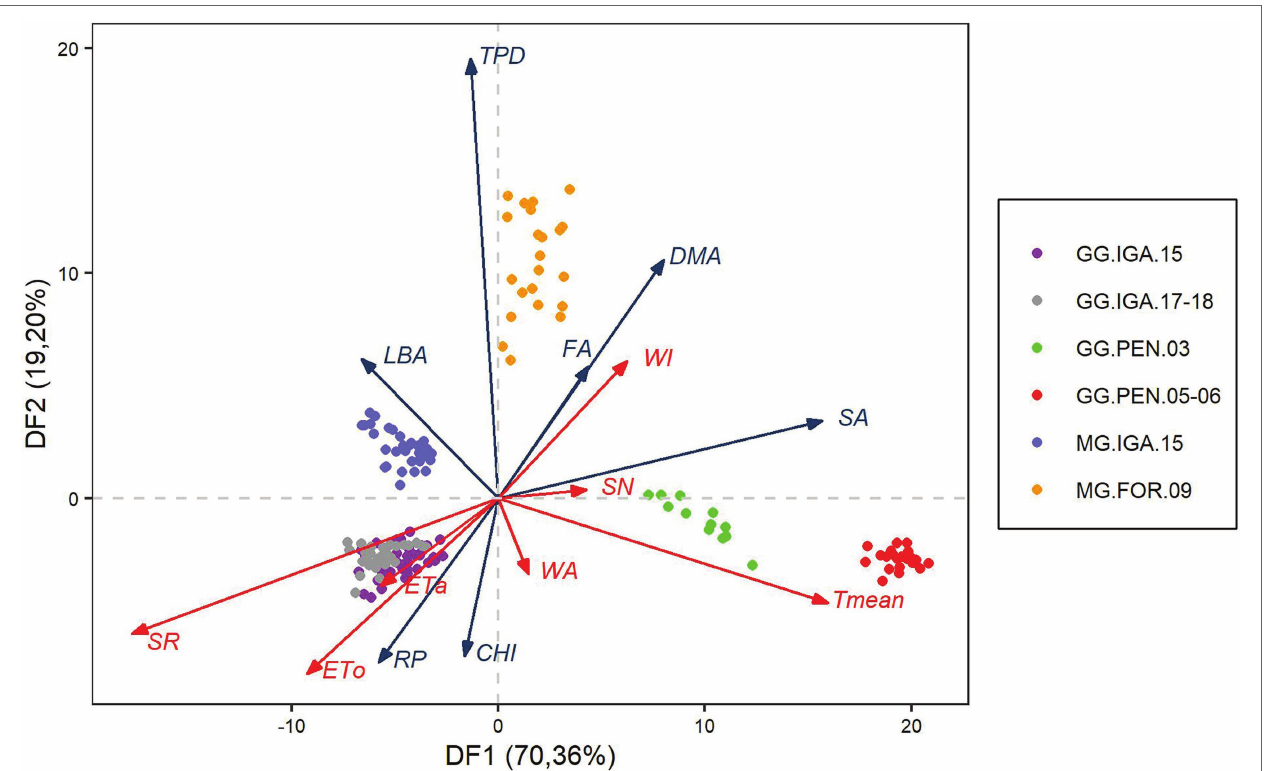
FIGURE 6 | Biplot representation of the first two discriminant functions with observations from six types of trials with cultivars of the species Megathyrsus maximus . The red and blue arrows show the participation of each agrometeorological and agronomic variable, respectively, in the formation of the discriminant function. ETa, Actual evapotranspiration; ETo, Reference evapotranspiration; SN, Supplied nitrogen; SR, Solar radiation; Tmean, Mean temperature; WA, Water applied; WI, Water index; CHI, Canopy height increment; DMA, Dead material accumulation; FA, Forage accumulation; LBA, Leaf blade accumulation; SA, Stem accumulation; and TPD, Tiller population